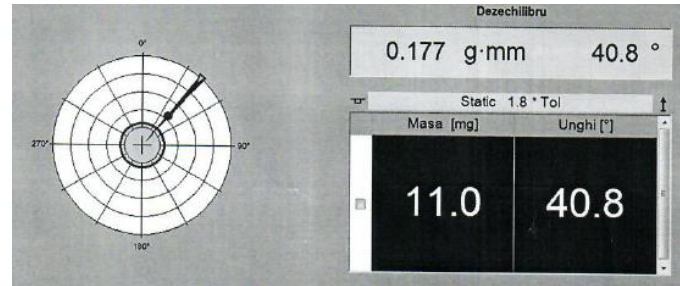
Figure 16. Unbalanced results after balancing operation. Figure 15. Unbalanced results after balancing operation.